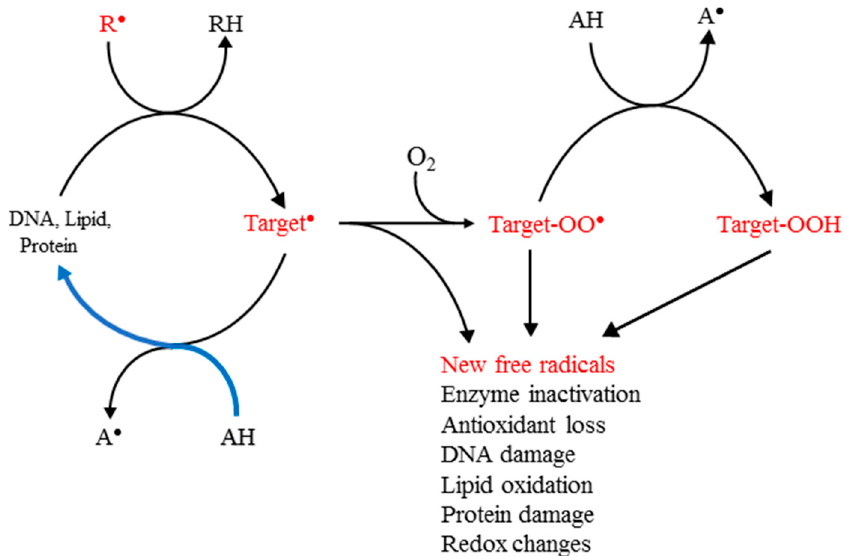
Scheme 1. Principal biological targets of the primary free radicals and damage repair. R • is the initiating free radical and AH an antioxidant. The initial reaction produces a carbon-centred free radical in the target. Reactive species are shown in red. The blue curve shows the flow of the reducing equivalents under optimal prevention of damage.